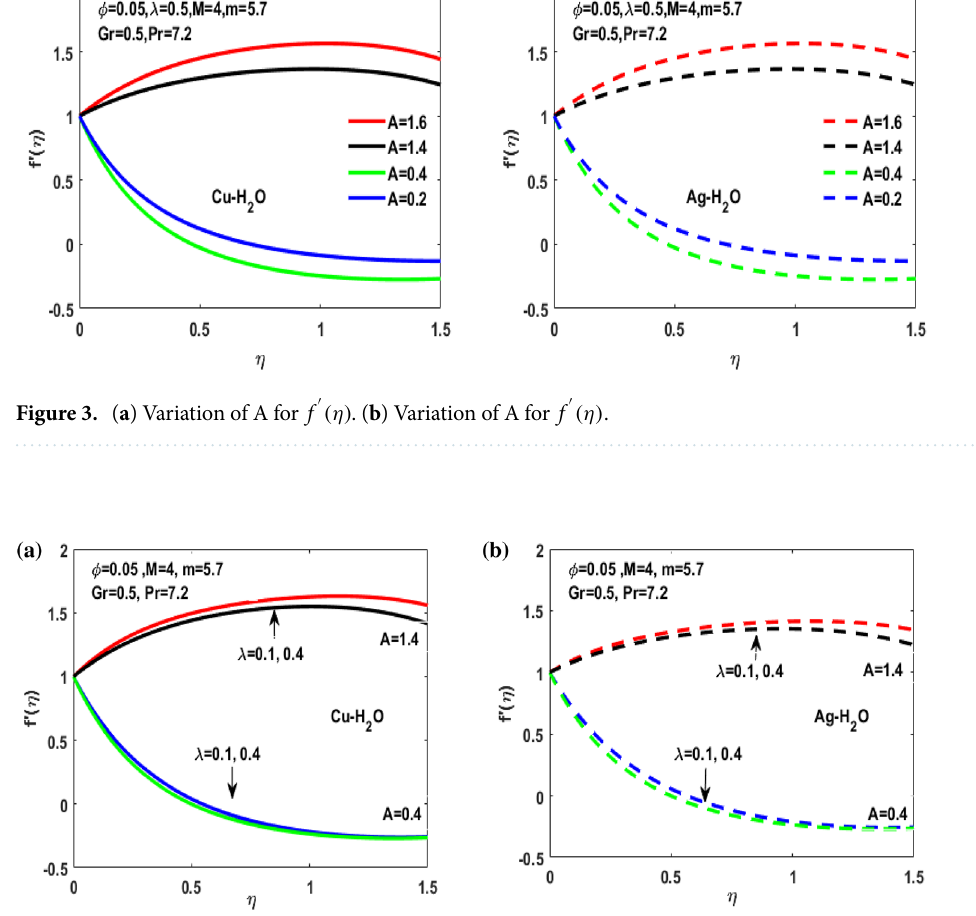
Figure 4. ( a ) Variation of (cid:31) for f ′ (η) . ( b ) Variation of (cid:31) for f ′ (η) .